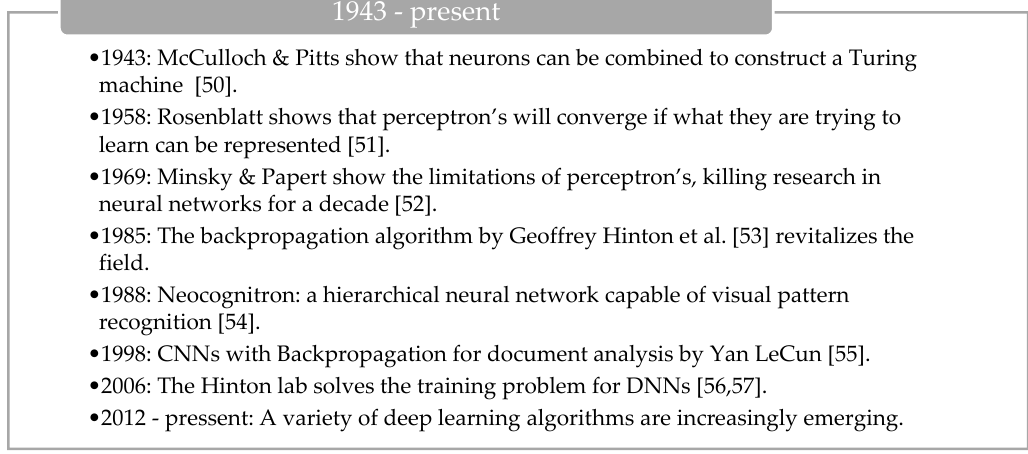
Figure 8. The history of deep learning development [50–57].